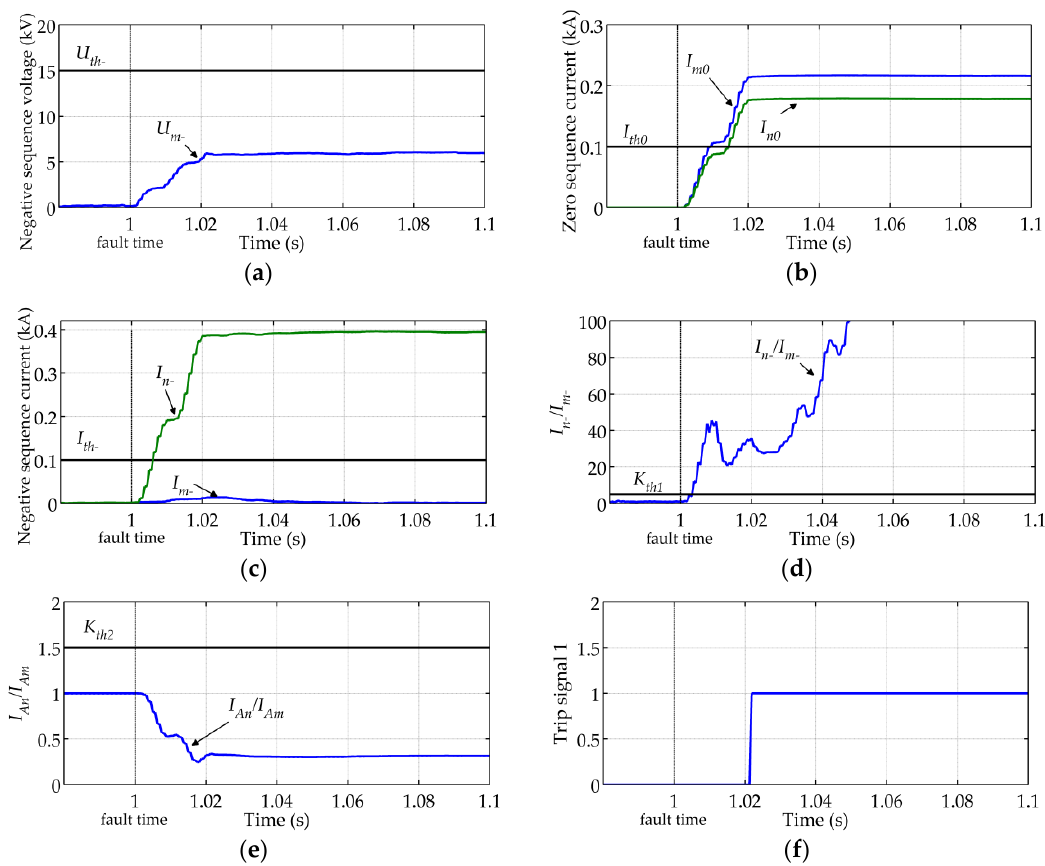
Figure 19. Values detected by relays and the trip signal under an internal phase-A-to-ground fault: ( a ) Magnitude of negative-sequence voltage at bus m side of line mn; ( b ) Magnitudes of zero-sequence currents at both sides of line mn; ( c ) Magnitudes of negative-sequence currents at both sides of line mn; ( d ) The ratio between negative-sequence currents flowing through both sides of line mn; ( e ) The ratio between phase A currents flowing through both sides of line mn; ( f ) The trip signal for unbalanced fault.